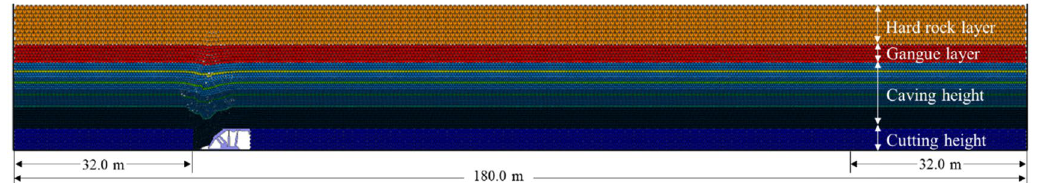
Figure 2. Numerical simulation model along the strike direction in LTCC working face.